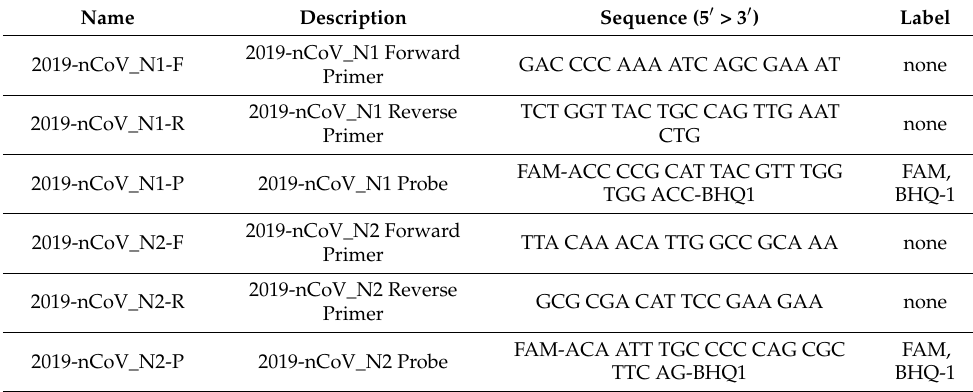
Table 1. qRT-PCR primers and